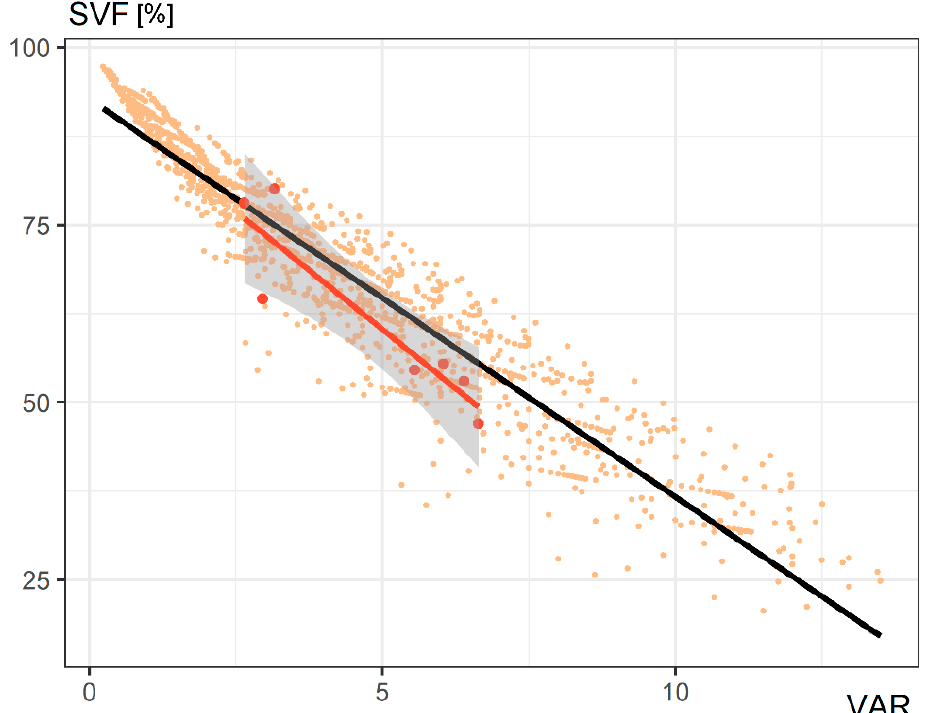
Figure 13. Linear regression function of metrics VAR and SVF based on neighbourhood iterations (black line) and case studies (red line), including the 95% CI for the case studies regression line indicated by the grey area.